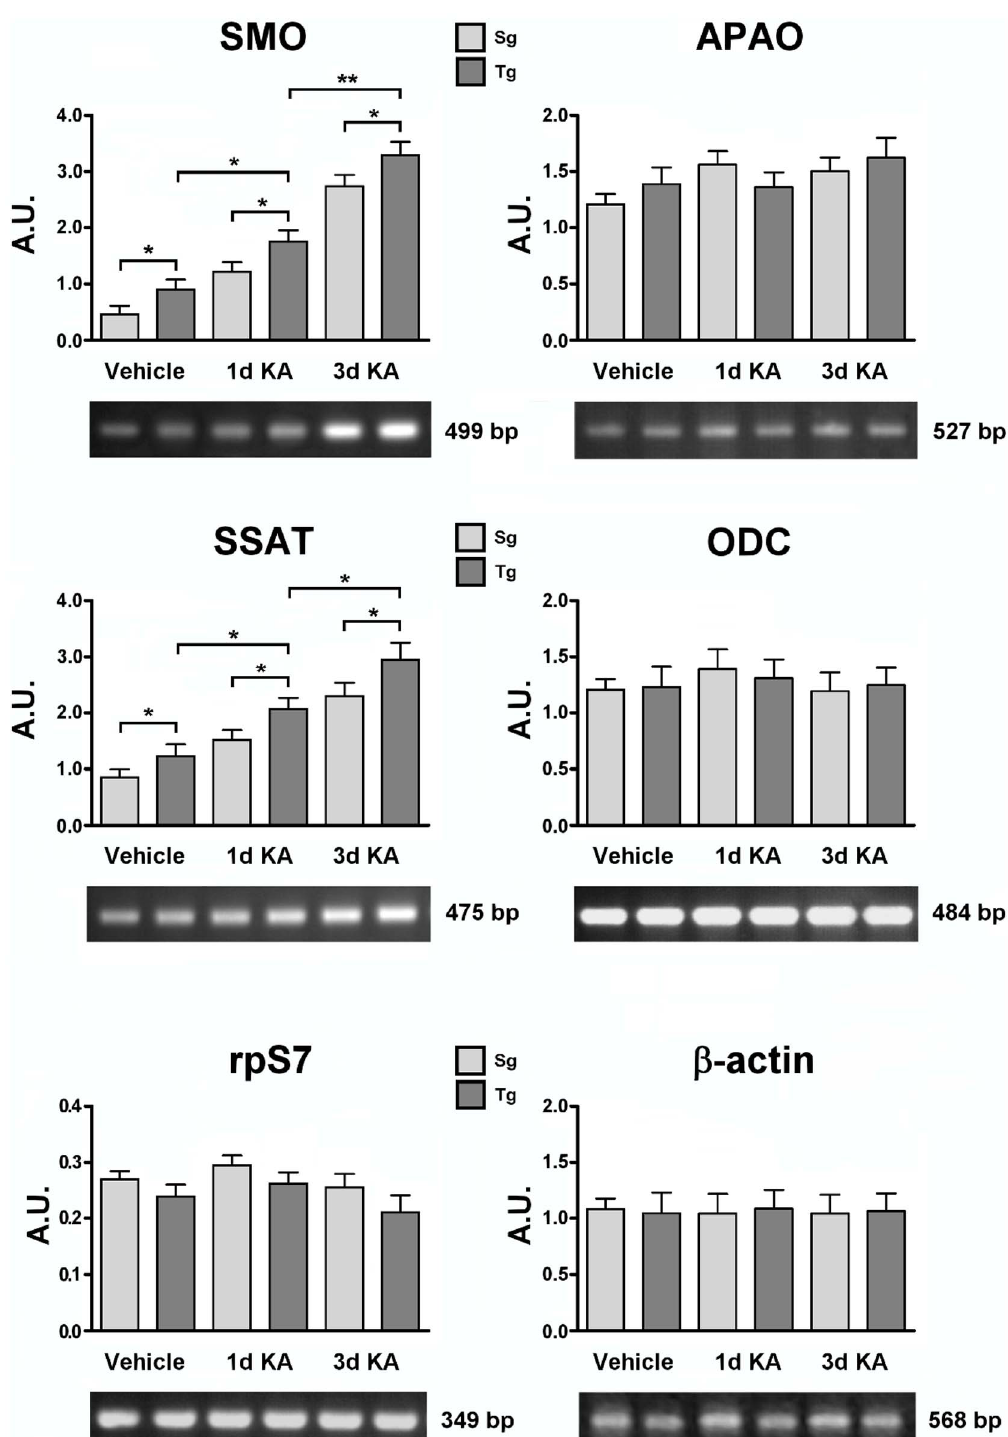
Figure 9. SMO, APAO, ODC and SSAT transcript level analyses of KA treated Tg and Sg mice. SMO, APAO, ODC and SSAT transcript accumulation of 3 months old mice were analyzed after 1 and 3 days of KA treatment. Representative RT-PCR experiments from three independent replicas are shown. Densitometric analyses of PCR gel bands, represent the measurements done on three separate experiments. The b -actin and/or rpS7 gene expression was used for normalization. An arbitrary densitometric unit bar graph (A.U.) is shown. The p values were measured with the two-way ANOVA test and post-hoc test Bonferroni (*, p , 0.05; **, p , 0.01). Sg, syngenic mice; Tg, transgenic mice.